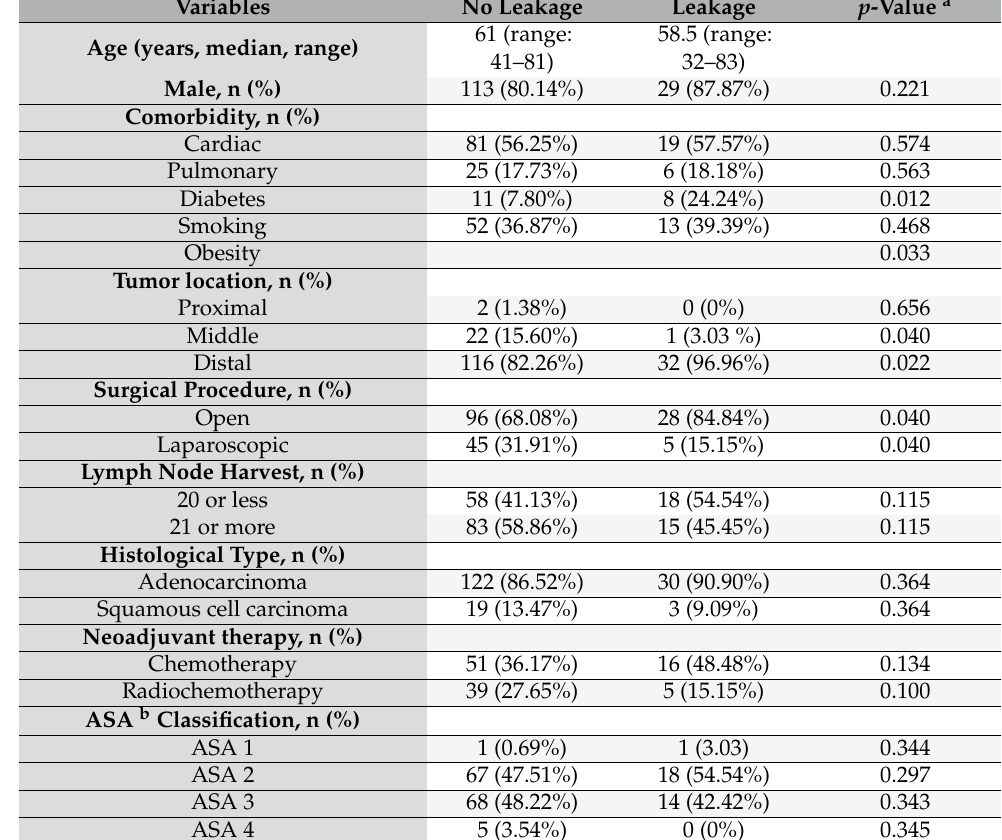
Table 1. Clinical and pathological characteristics in correlation with intrathoracic anastomotic leakage. Variables